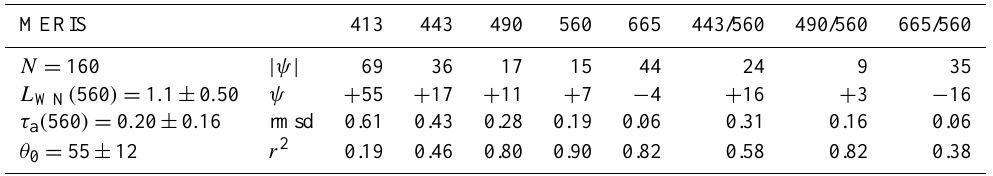
Table 1. Statistical results from the analysis of MERIS (2rd Reprocessing) and AERONET-OC L WN , and their ratios at specific center wavelengths for the match-ups determined at the AAOT with 1t = ± 1h. The quantities | ψ | and ψ are in % while rmsd is in units of the quantity compared ( L WN or ratio). The number of match-ups N , and, the averages of L WN at 560nm, aerosol optical thickness τ a at 869nm, and Sun zenith angles θ 0 from in situ data, are given in the first column (where the ± values indicate the standard deviation).